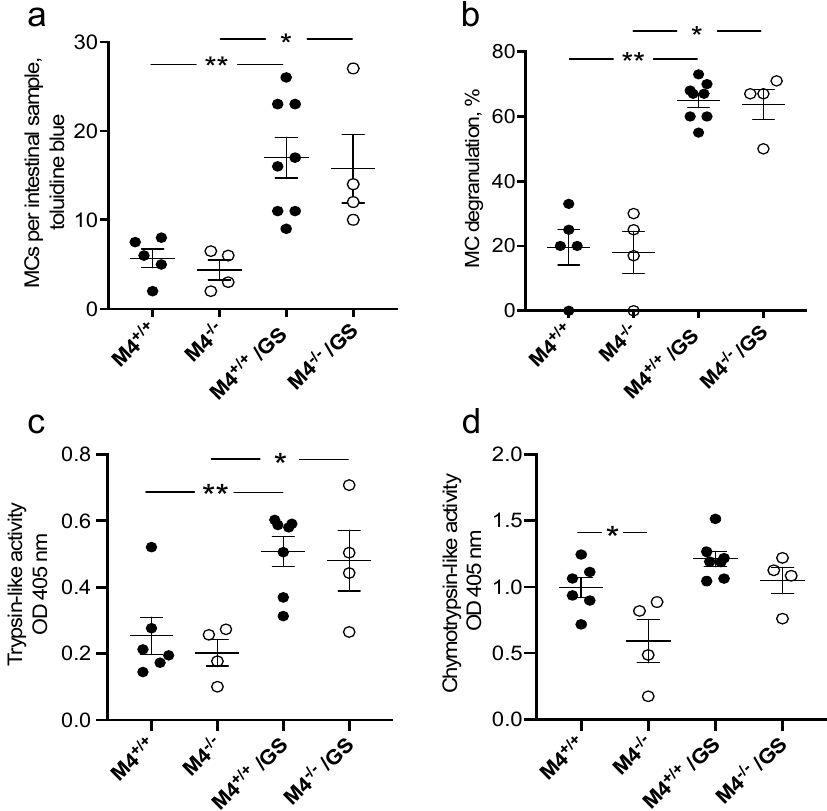
Figure 2. Increased mast cell counts, degranulation and trypsin-like activity in the small intestine during infection with Giardia intestinalis . Small intestinal sections from non-infected and >18-week-old mice 8 dpi were stained with toluidine blue (TB), and ( a ) submucosal mast cells were counted and ( b ) degranulation status of the mast cells were scored. ( c ) Trypsin-like and ( d ) chymotrypsin-like activity in intestinal tissue of 8 dpi mMCP-4 +/+ and mMCP-4 − / − littermate mice and in non-infected littermate mice. * and ** represents p < 0.05 or 0.01 for infected mice vs. noninfected mice.